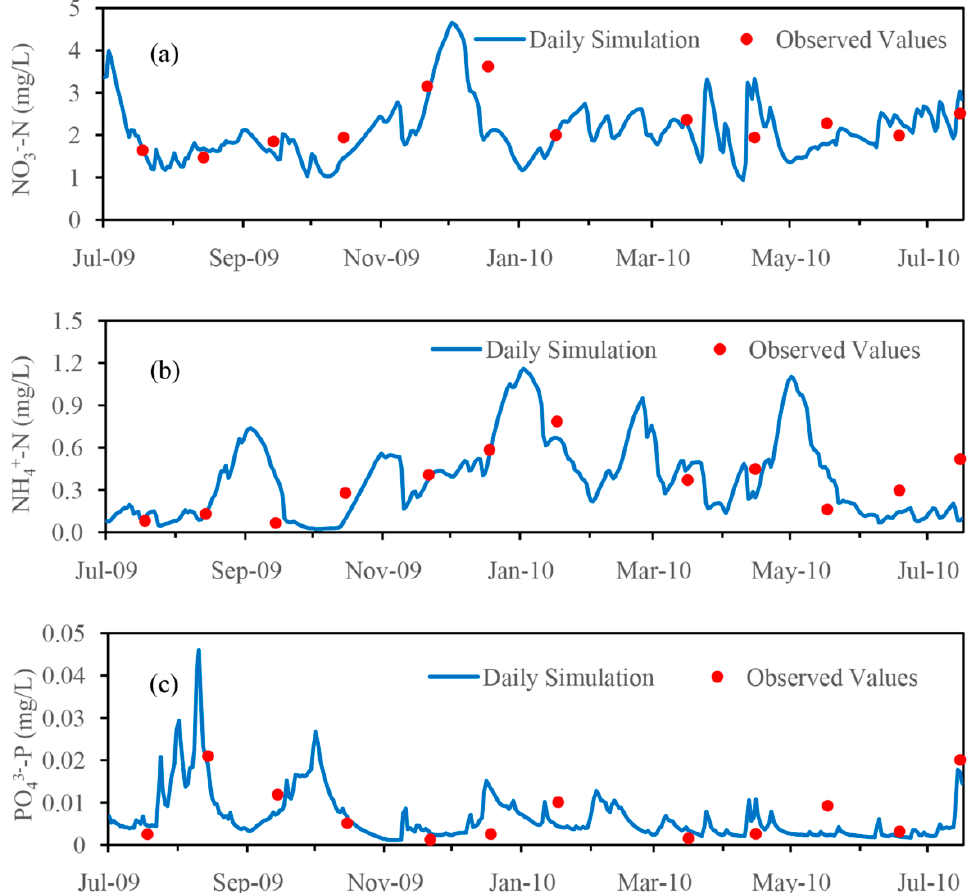
Figure 7. Comparison of the simulated and observed nutrient concentrations for the calibration at the Hengtang station (July 2009–July 2010). ( a ) NO 3 − -N; ( b ) NH 4 + -N; ( c ) PO 4 3 − -P.